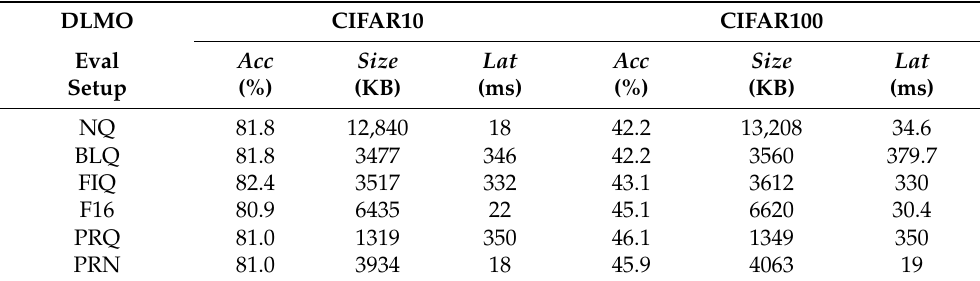
Table 8. MobileNet v1.